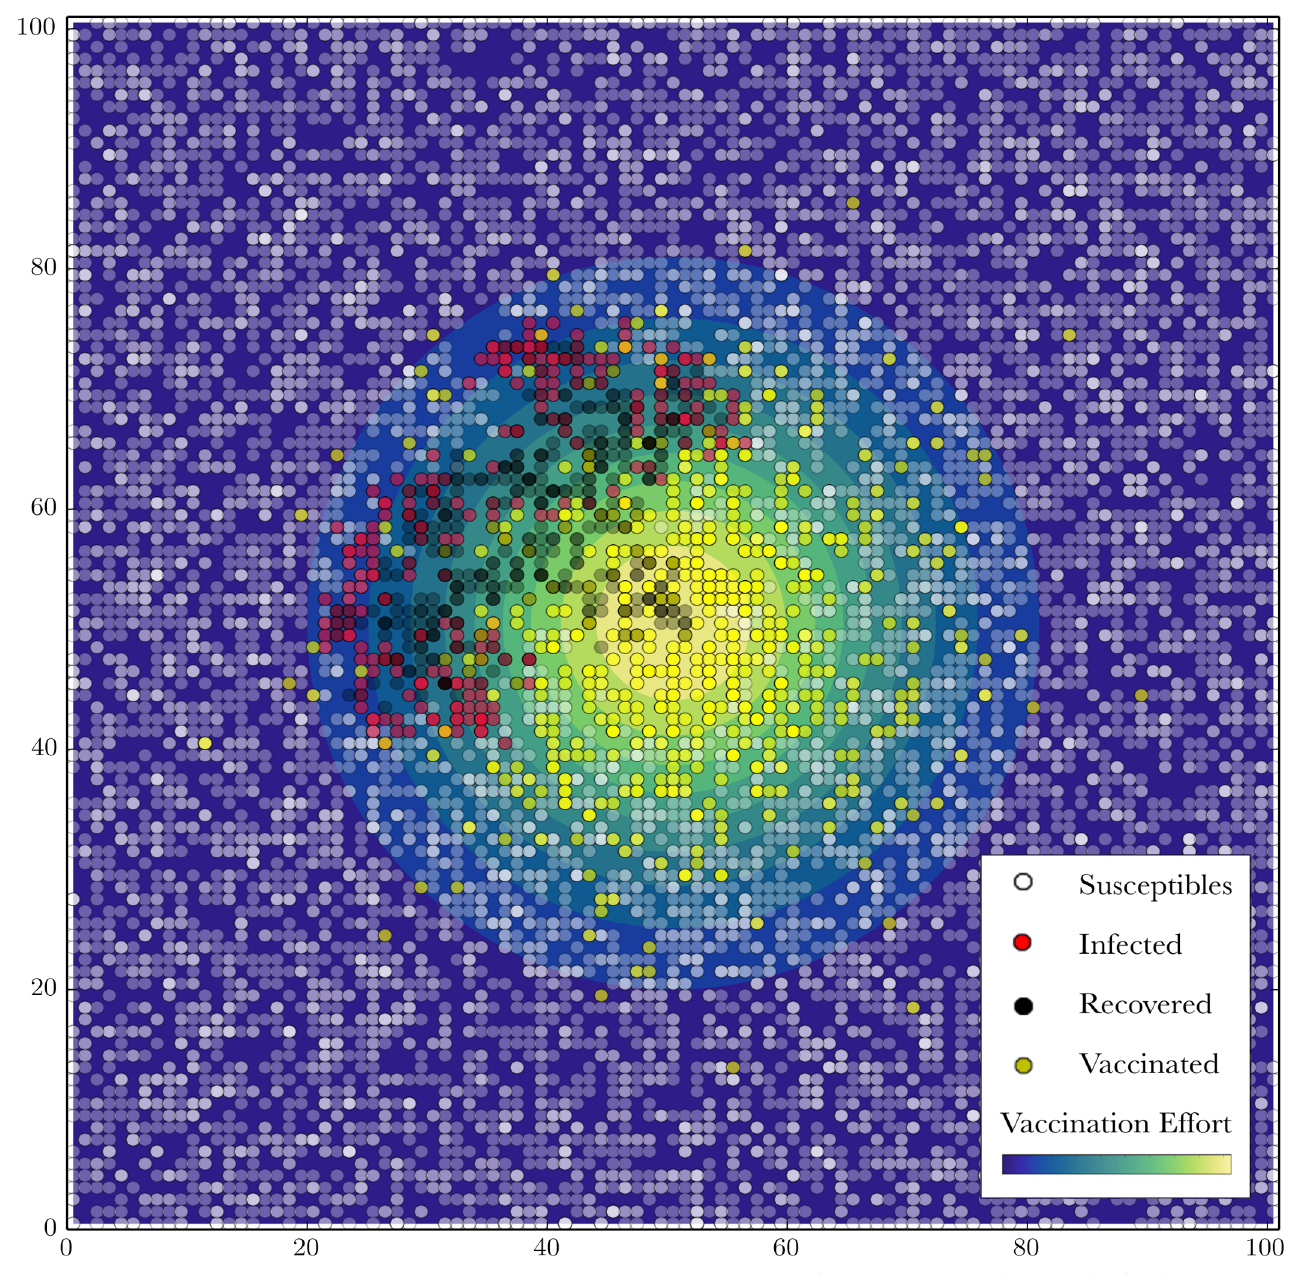
Fig 1. Snapshot of simulated timely vaccination response to an escaping outbreak. Image captured at time t = 4 in a population initialized with N = 10201 susceptibles, vaccination diffusion rate μ = 25, time step τ = 0.1, transmission rate δ = 2, recovery rate ρ = 0.2, vaccine intensity ε = 20, and interaction scale α = 1. See S1 Video for the full visual